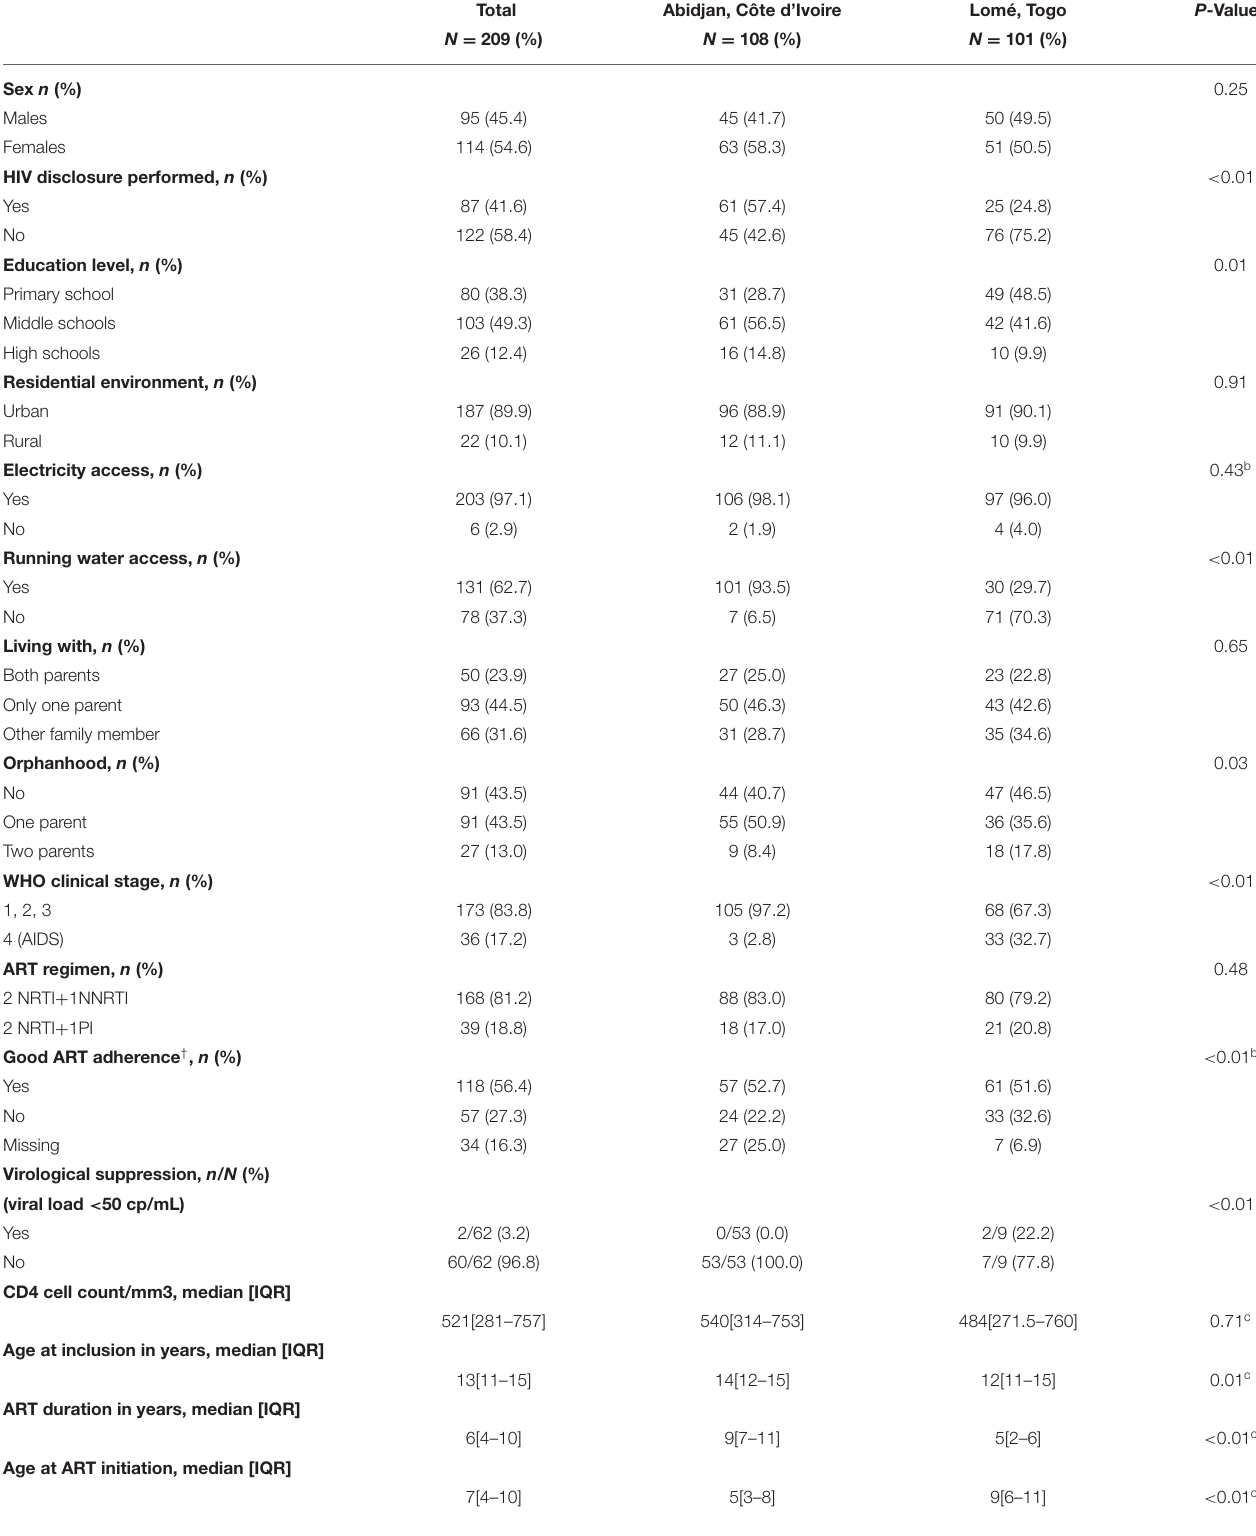
TABLE 2 | Baseline characteristics of the 209 adolescents living with perinatally-acquired HIV included in the COHADO cohort according to sites, Abidjan (Côte d’Ivoire), Lomé (Togo) IeDEA-pWADA, 2015–2017. Total Abidjan, Côte d’Ivoire Lomé, Togo P -Value